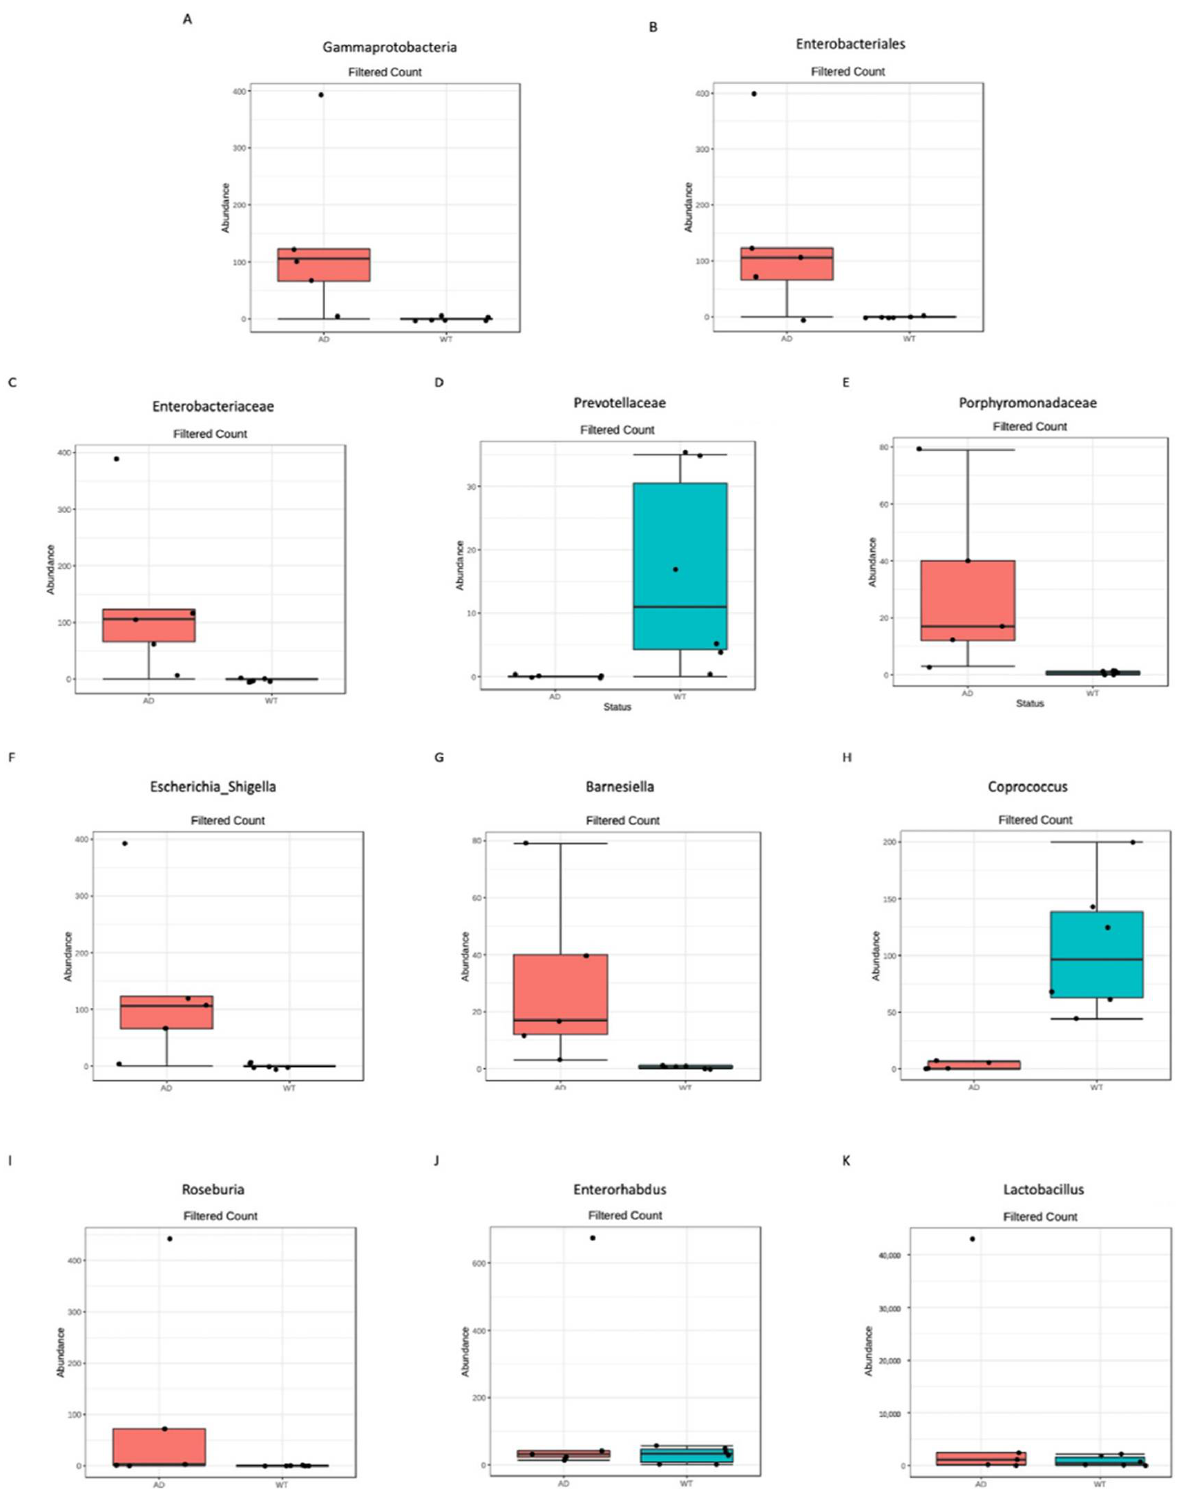
Figure 3. Significantly different taxa identified between AD and WT mice. Differential abundance analysis was performed to highlight significantly different taxa using DESeq2, p -value < 0.05 after FDR correction; 1 class ( A ), 1 order ( B ), 3 families ( C – E ), and 6 genera ( F – K ) resulted in significant differences between the 2 tested conditions.